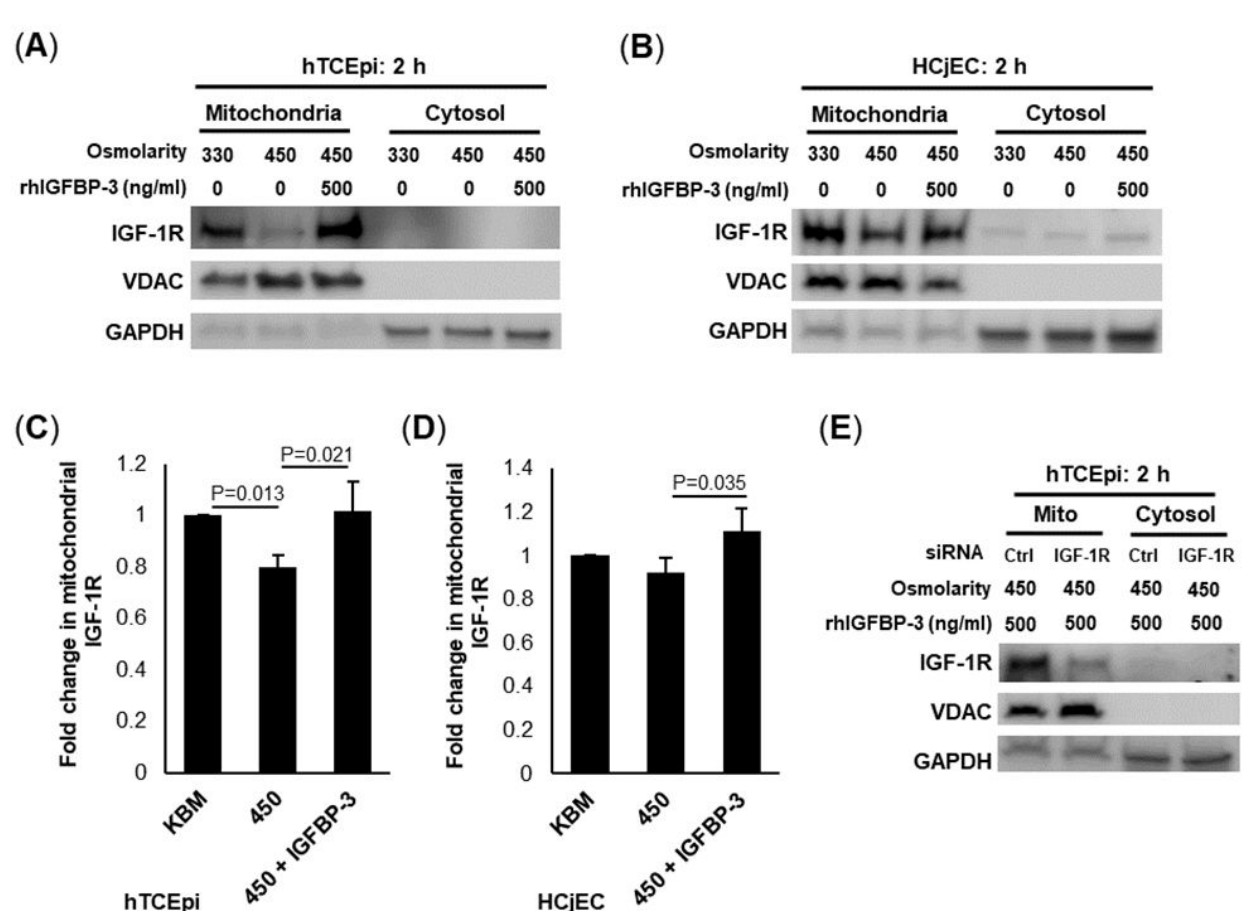
Figure 3. IGFBP-3 promotes IGF-1 receptor (IGF-1R) accumulation in mitochondria during